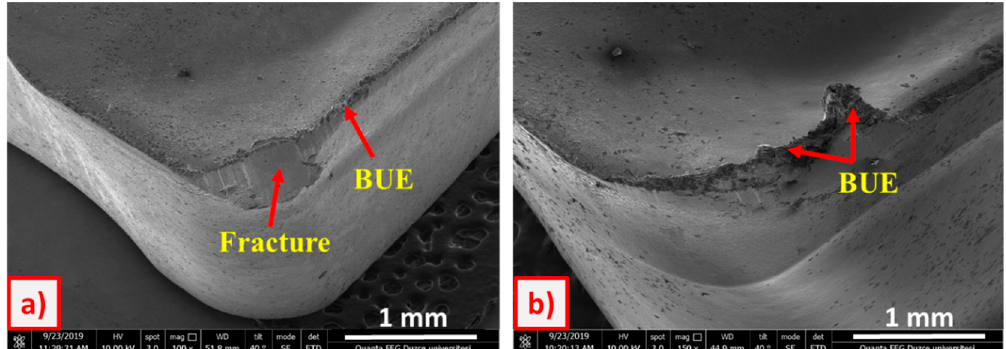
Figure 9. SEM images of tool wear that occur on cutting tools as a result of the milling of NiTi SMA ( a ) with the cutting tool with 0.4 mm r ε , at high V c (50 m/min) and f z (0.14 mm/tooth) and ( b ) with the cutting tool with 0.8 mm r ε , at low V c (20 m/min) and f z (0.03 mm/tooth).